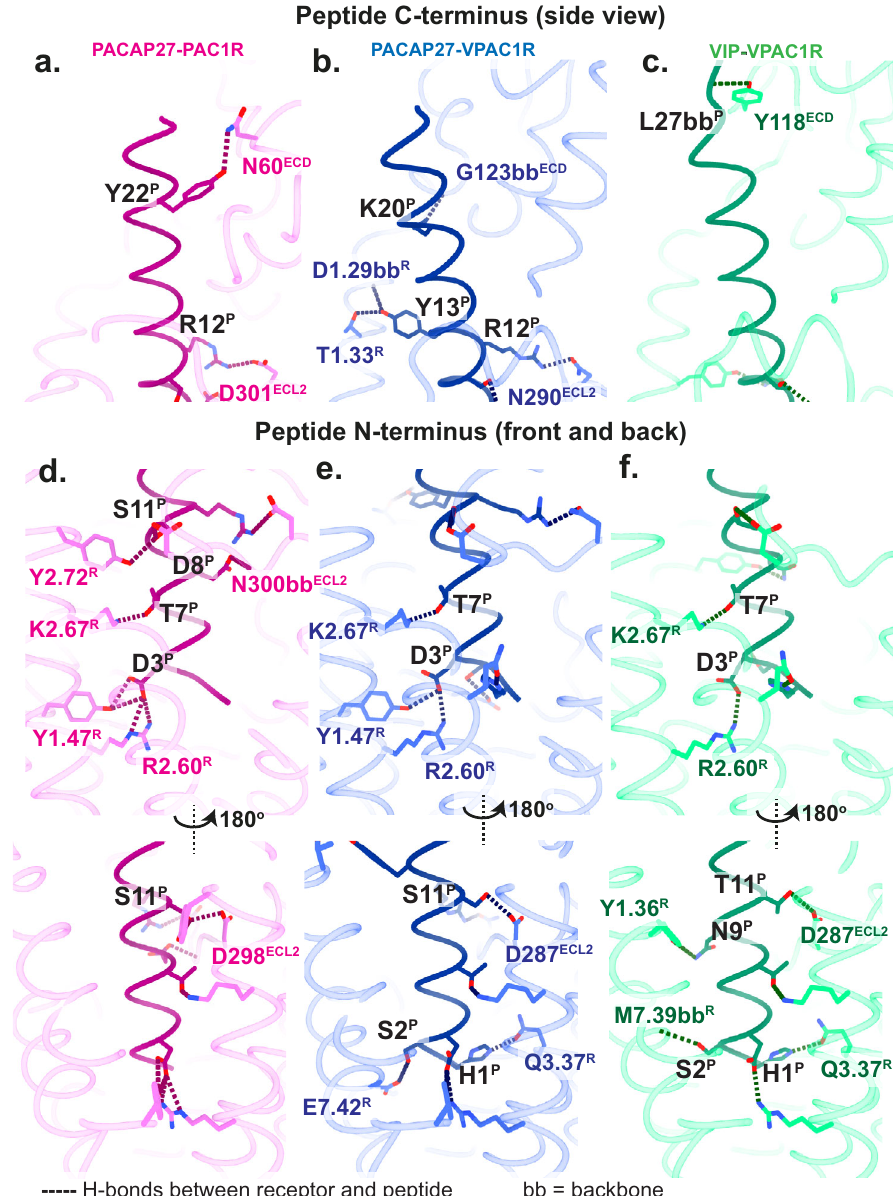
Fig. 2 | Hydrogen bonds between peptide (P) and receptor (R) residues in the static structures. The receptor backbone is displayed in transparent in ribbon formatandpeptidebackboneinribbonformat,withsidechainsthatareinvolvedin H-bonds displayed in stick format. PAC1R-PACAP27 is shown in pink-dark pink, VPAC1R-PACAP27 in blue-dark blue and VPAC1R-VIP in green-dark green. a – c Interactions of the peptide C-terminus and the receptor shown as side view.